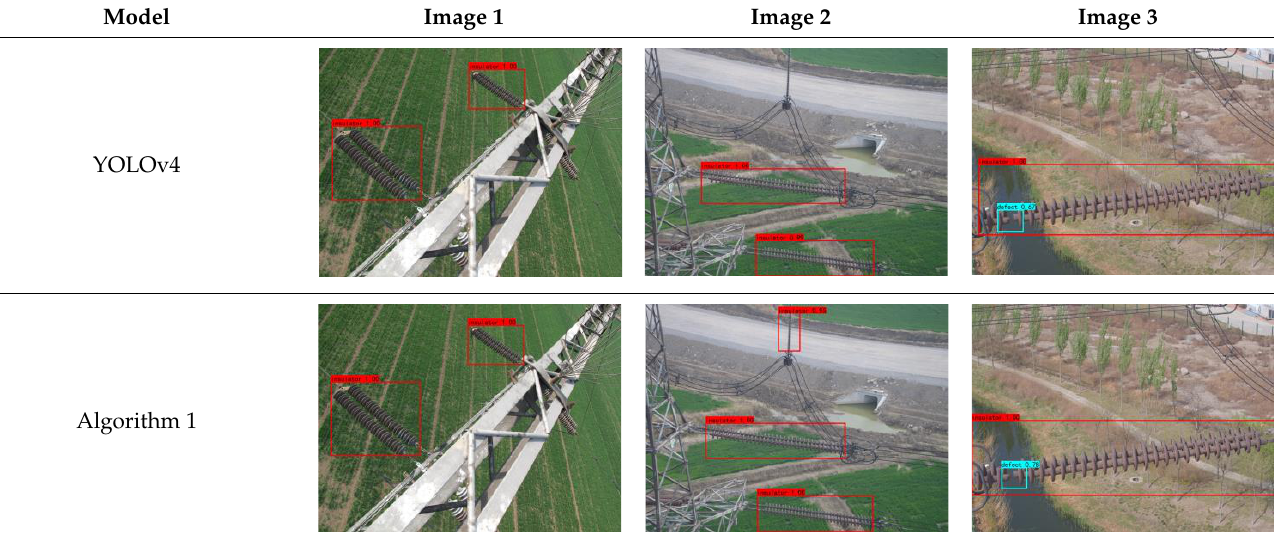
Table 4. Test image comparison.